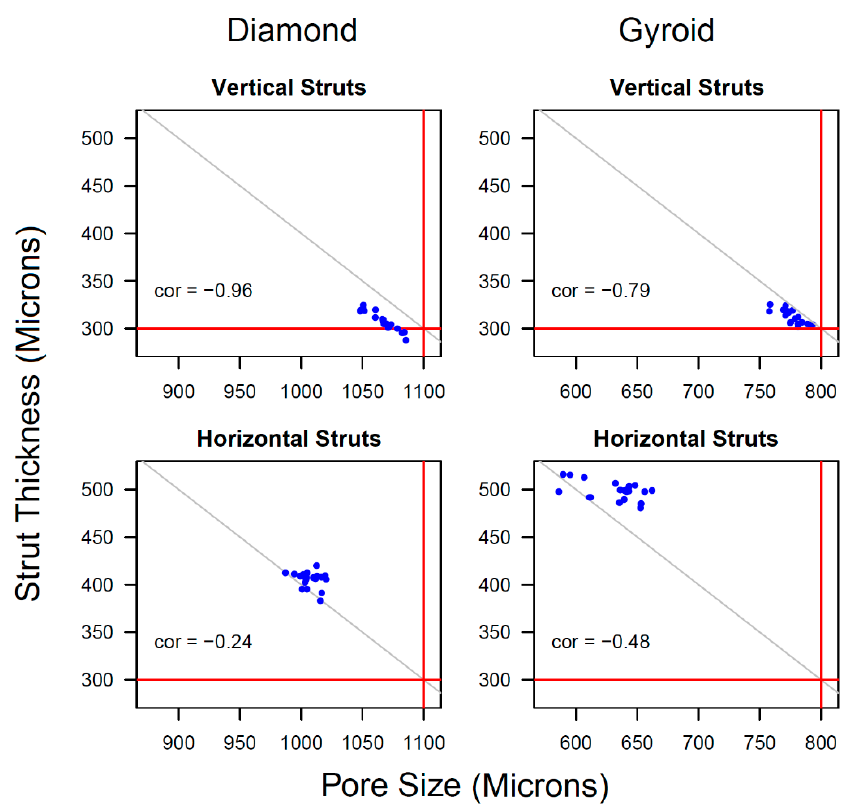
Figure 7. Mean strut thickness plotted against mean pore size for each slice within each replicate structure, for each combination of structure type and strut orientation. There are 20 points in each panel, each being the mean of the 30 measurements in the same slice. The red lines show the target values for each variable. The grey line in each panel is given by the equation x + y = tS + tP, where tS and tP are the target values for strut thickness and pore size, respectively. The same axis scales were used in all panels, except that the location of the pore size scale, which differed for diamonds and gyroids because of their different target values.